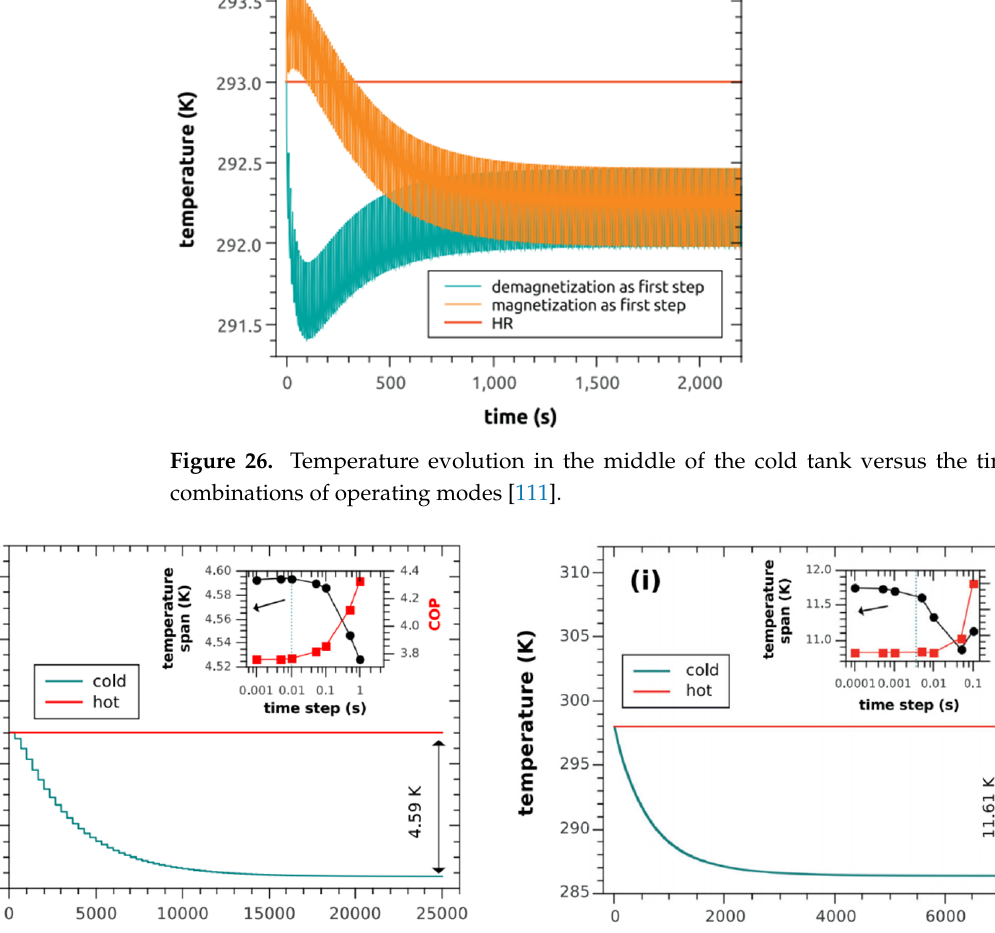
Figure 26. Temperature evolution in the middle of the cold tank versus the time for the best com- binations of operating modes [111].